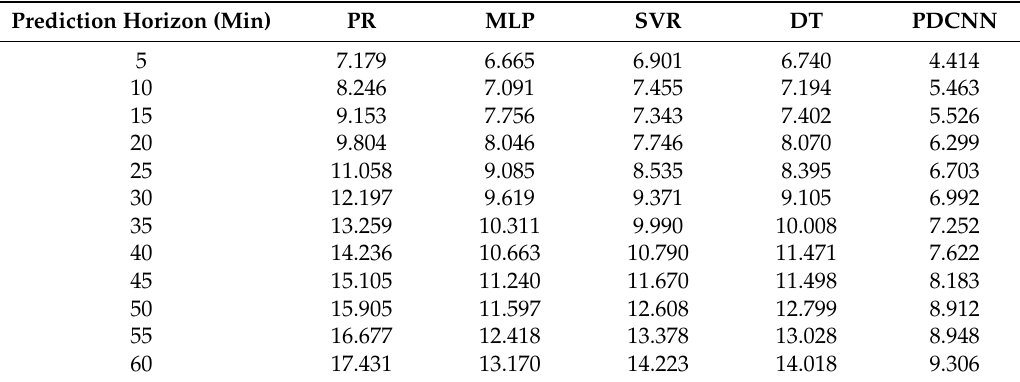
Table 2. A-MAPE of Prediction Models for Different Time Horizons (%).